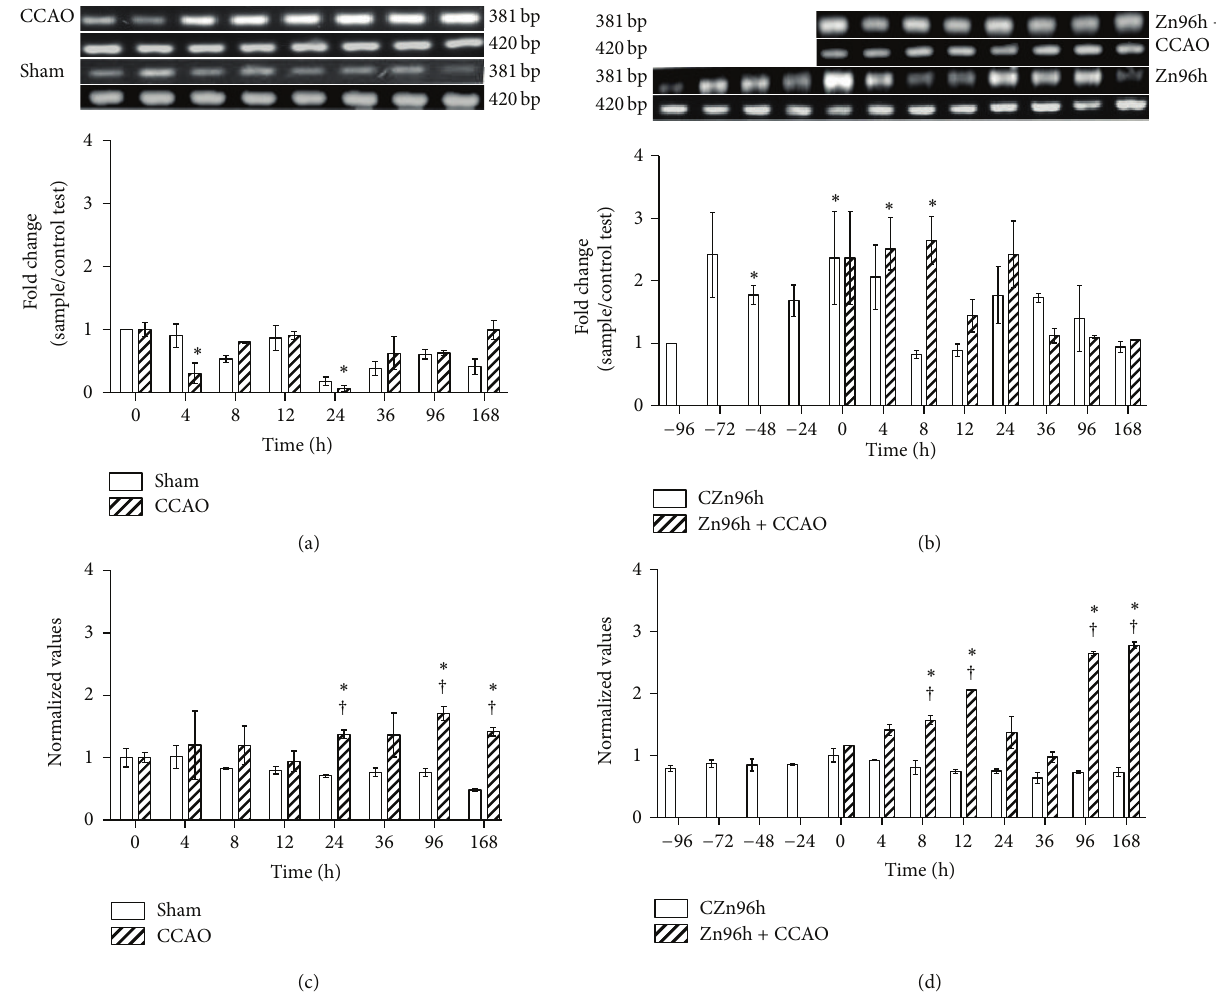
Figure 6: The subacute administration effect of zinc on levels of IGF-1 expression after hypoxia-ischemia in rats. RT-PCR was used to determine mRNA levels of IGF-1 (381bp) and GA3PDH (420 bp). ((a) and (b)) Showing representative photographs of ethidium-bromide- stained RT-PCR products fractionated on 2% agarose gel and the respective densitometry analysis. ((c) and (d)) Showing the IGF-1 protein levels measured using ELISA. Each value represents the mean ± SEM of 5 independent experiments in triplicate. (1) Zn96h, rats injected with ZnCl 2 (one dose every 24 h during 4 days). (2) Zn96h + CCAO, rats treated with zinc before 10min of common carotid artery occlusion (CCAO). (3) CCAO, rats with CCAO only. (4) Sham group, rats with mock CCAO. (5) Untreated rats. ∗ , significant when compared with the control group; ANOVA test and post hoc Dunnett’s test. † , significant when compared between groups; unpaired Student’s 𝑡 -test. 𝑃 < 0.05